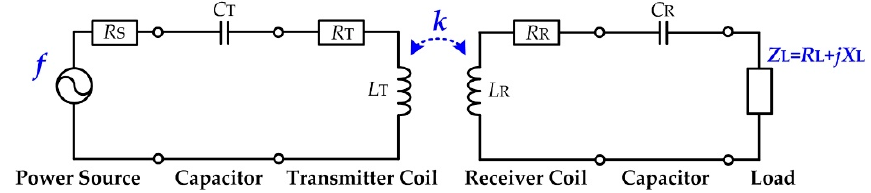
Figure 9. The SS compensated WPT system.